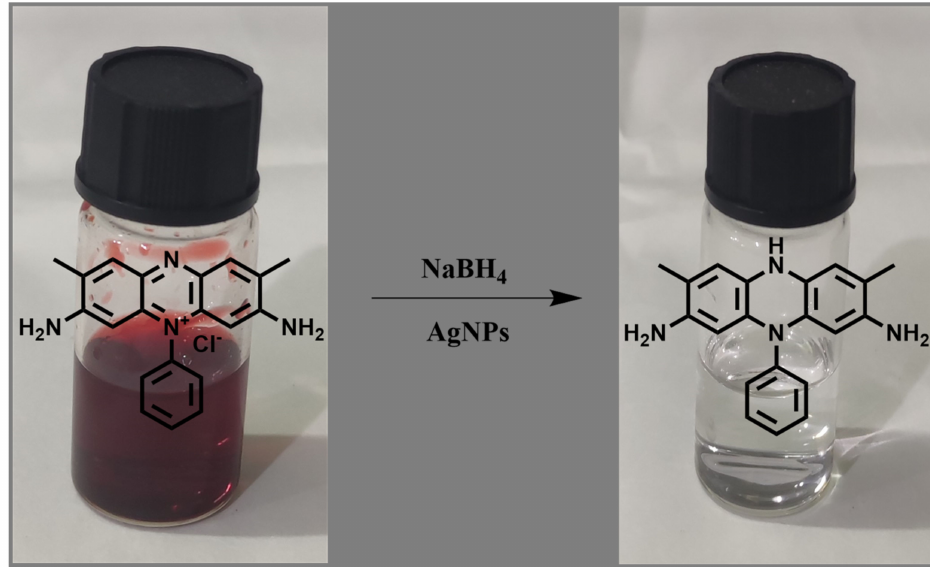
Figure 18. Possible mechanism of degradation of Safranin O.